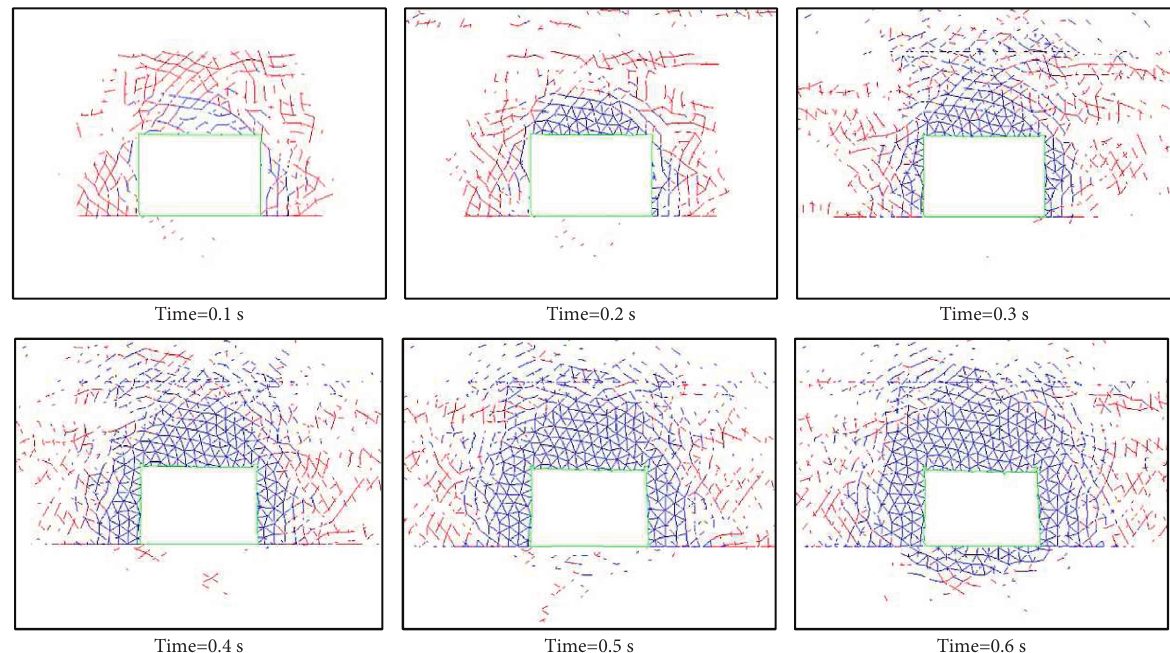
Figure 9: Characteristics of mesocrack evolution (red is the shear crack, blue is the tensile crack).